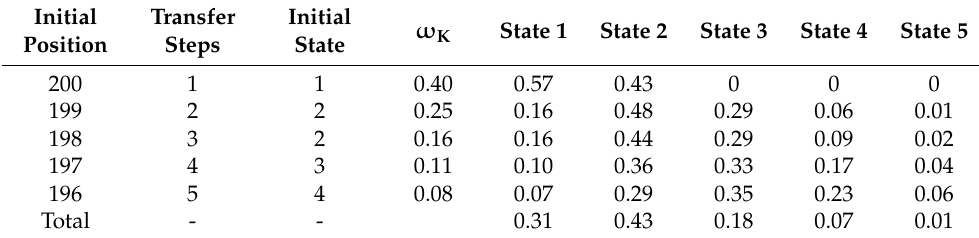
Table 13. State prediction of residual relative value by the improved grey Markov